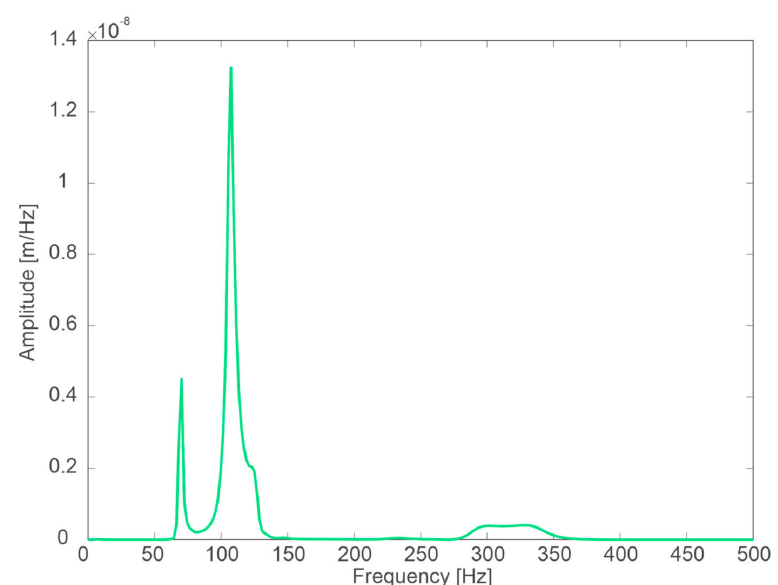
Figure 20. Spectrum generated from vertical displacement in the direction y of the capsule at a speed of 1000 km / h.